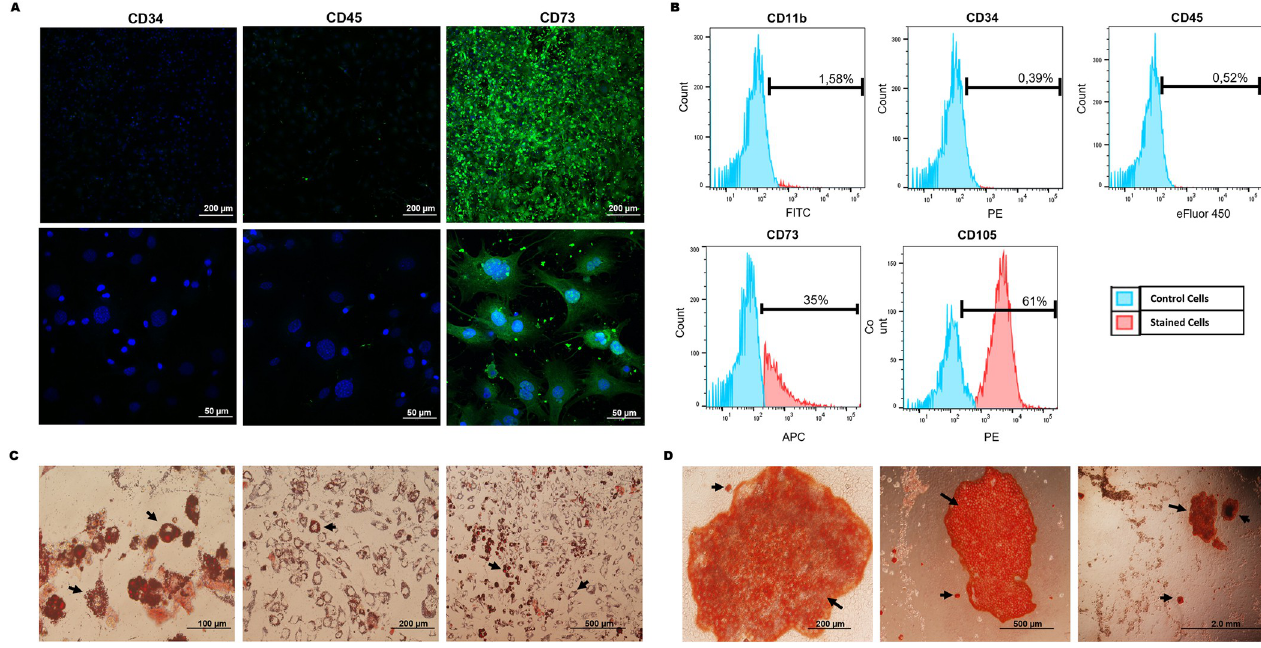
Fig 1. MSC characterization. (A) MSC immunofluorescence staining with positive (CD73, in green) and negative (CD34, CD45) markers. The nuclei were stained with DAPI (in blue). (B) Flow cytometry phenotyping of MSCs (CD11b, CD34, CD45, CD73, CD105). (C) Qualitative assay of adipogenesis. The arrows indicate lipid droplets stained with Oil Red. (D) Qualitative assay of osteogenesis. The arrows indicate calcium deposits stained with Alizarin Red.